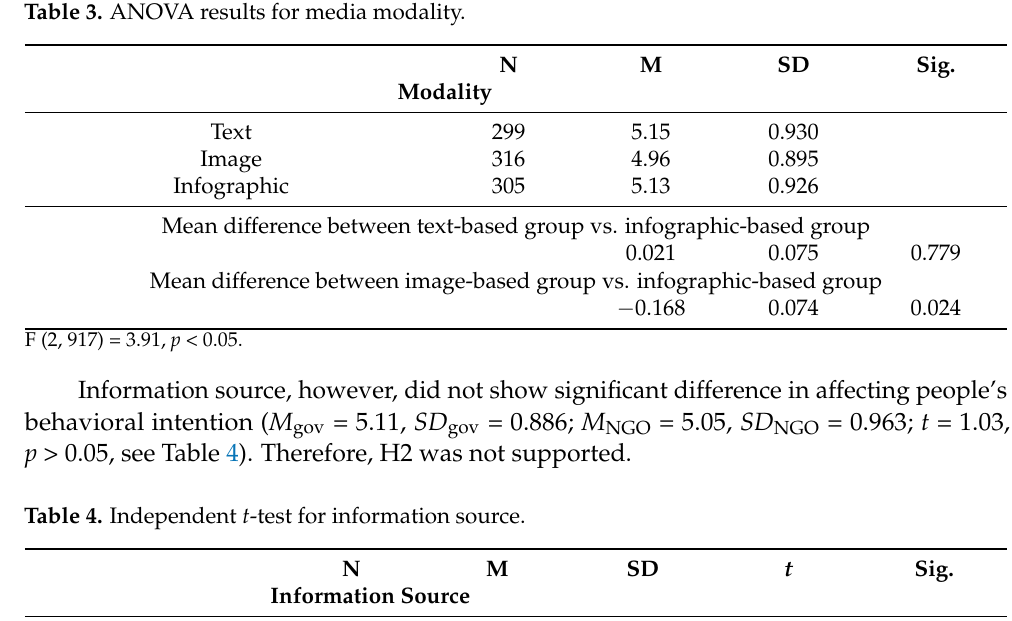
Table 3. ANOVA results for media modality.